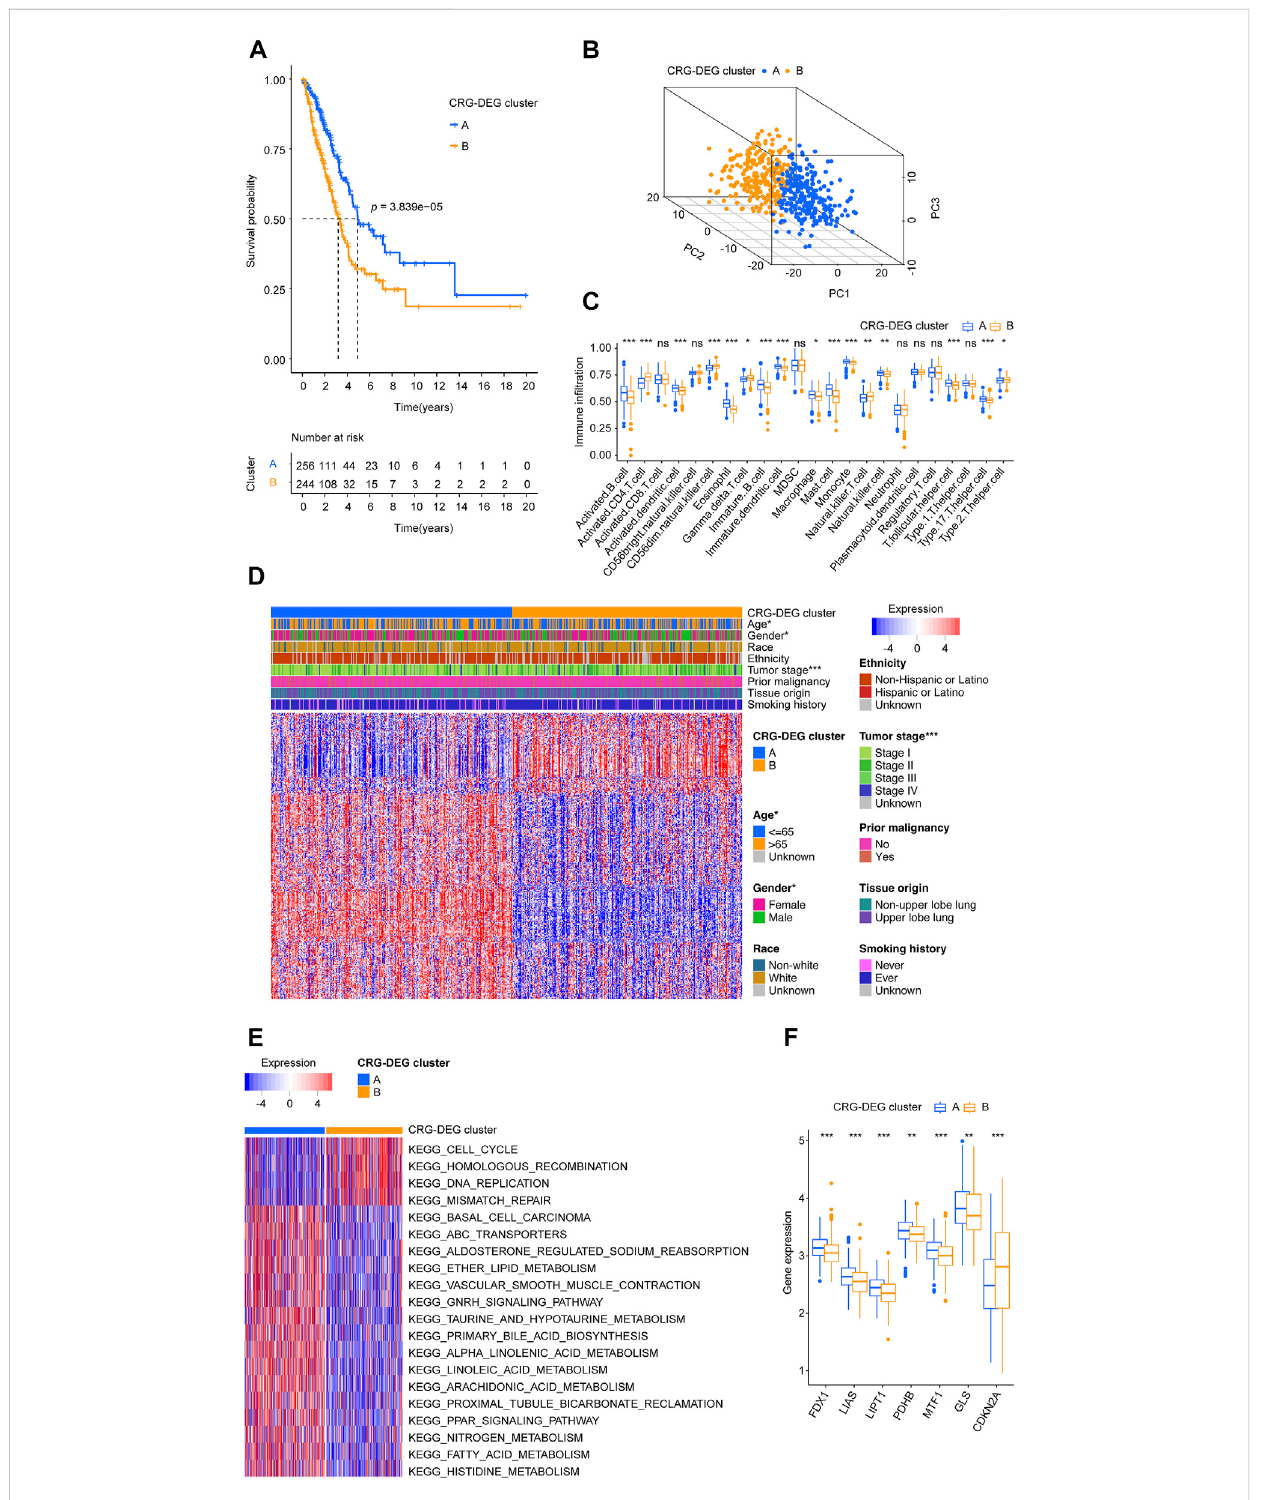
FIGURE 3 Two CRG-DEG clusters identi fi ed. (A) The KM survival curve demonstrated that the overall survival of patients in the CRG-DEG clusters were signi fi cantly different. (B) Principal component analysis scatter plot shows three clusters were obviously separated. (C) In fi ltration distribution of immune cells in the two CRG-DEG clusters. (D) Heatmap shows the relationship between CRG-DEG clusters, clinical parameters, and 344 CRG-DEGs. Each row represents a gene, and each column represents a sample. (E) GSVA screens the most important KEGG pathways by comparing two CRG-DEG clusters. (F) Boxplots shows the distribution of ten CRGs (FDX1, LIAS, LIPT1, DLD, DLAT, PDHA1, PDHB, MTF1, GLS, and CDKN2A) across CRG-DEG clusters. CRG: cuproptosis-regulated gene; DEGs: differentially expressed genes; KM: Kaplan – Meier estimator; GSVA: gene set variation analysis; KEGG: Kyoto Encyclopedia of Genes and Genomes; p-value < 0.05 was considered statistically signi fi cant; ns: not signi fi cant; *: p- value < 0.05; **: p- value < 0.01; ***: p-value <